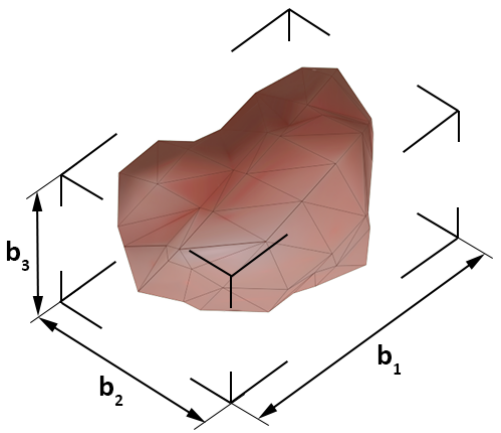
Figure 4. Definition of box